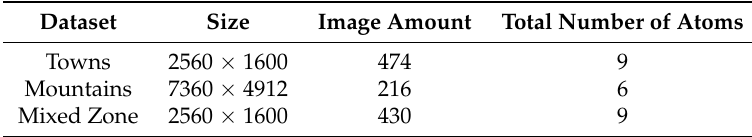
Figure 6. ( a ) UAV platform flying over the Qinling mountains; ( b ) example of image acquisition area visualized by Google Earth, in which the area surrounded by the yellow bounding box denotes an area of 57 square kilometers. ( c ) Typical aerial images. Table 1. Details of aerial image datasets and image clustering results of our